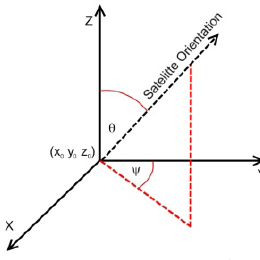
Figure 2. Orientation parameters of the test